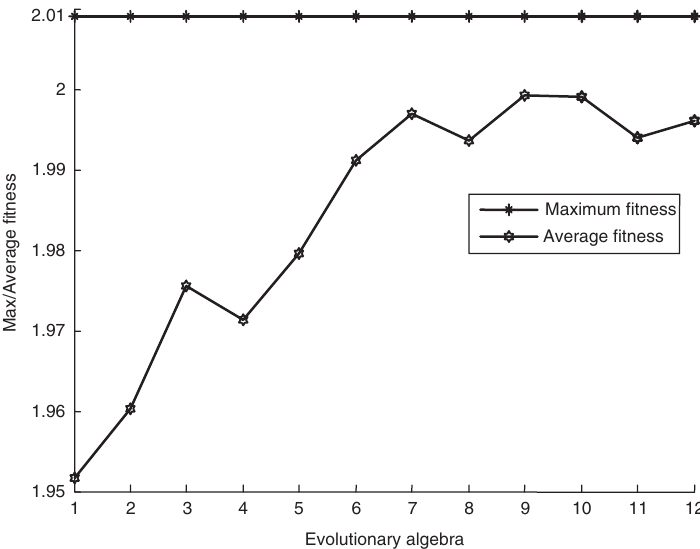
Figure 2: Smooth Factor Fitness Curve of the Railway Freight Increment in